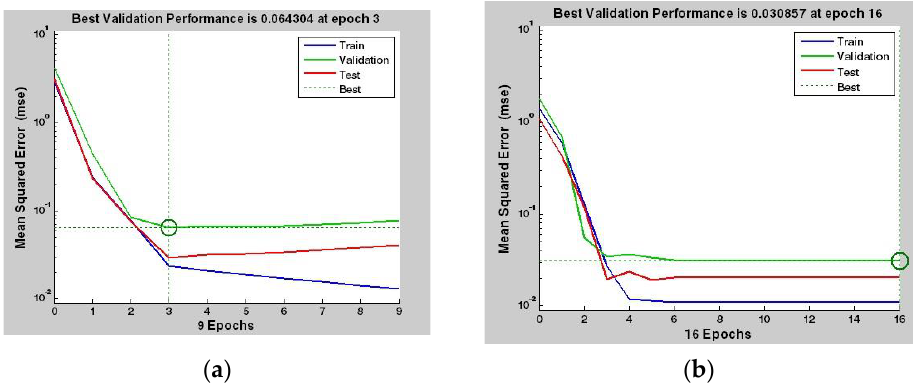
Figure 7. Error reduction trend in EM prediction ( a ) and UCS ( b ) using optimum BPNN.